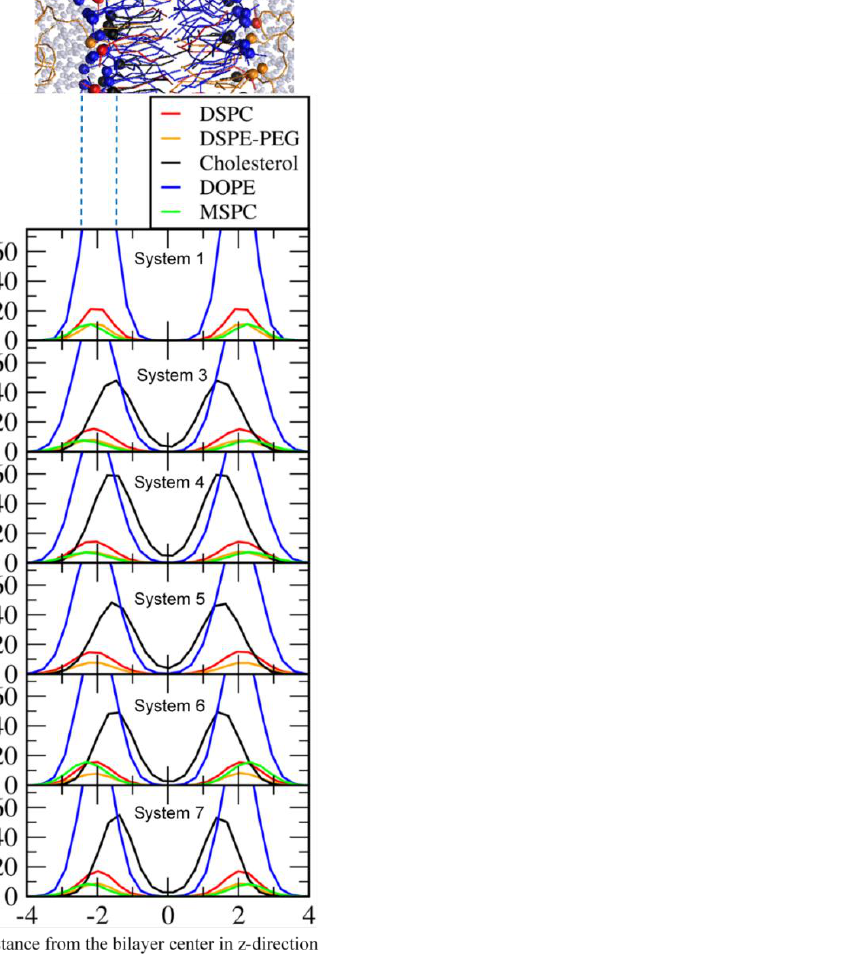
Figure 2. Mass density profiles for the phosphate groups of lipids and the hydroxyl group of cho- lesterol.